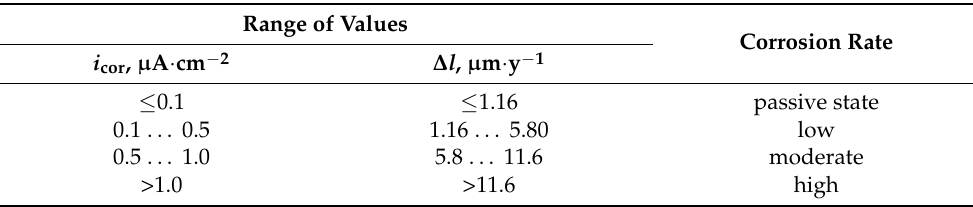
Table 3. Values of corrosion current density ( i cor ) and cross-section loss ( ∆ l ) of reinforcement for assessing the